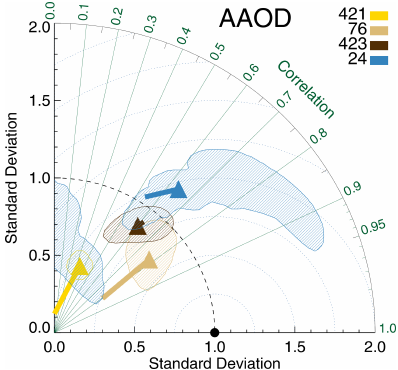
Figure 6. Impact of statistical noise on the correlation and internal variability of satellite AAOD products, using bootstrapping. Shaded regions indicate a 5%–95% uncertainty range of correlation and standard deviation (uncertainty in bias is not shown). Colours in- dicate the satellite product (see also Fig. 1), and numbers next to coloured blocks indicate the amount of collocated data. Satellite products were individually collocated with AERONET Inversion L2.0 within